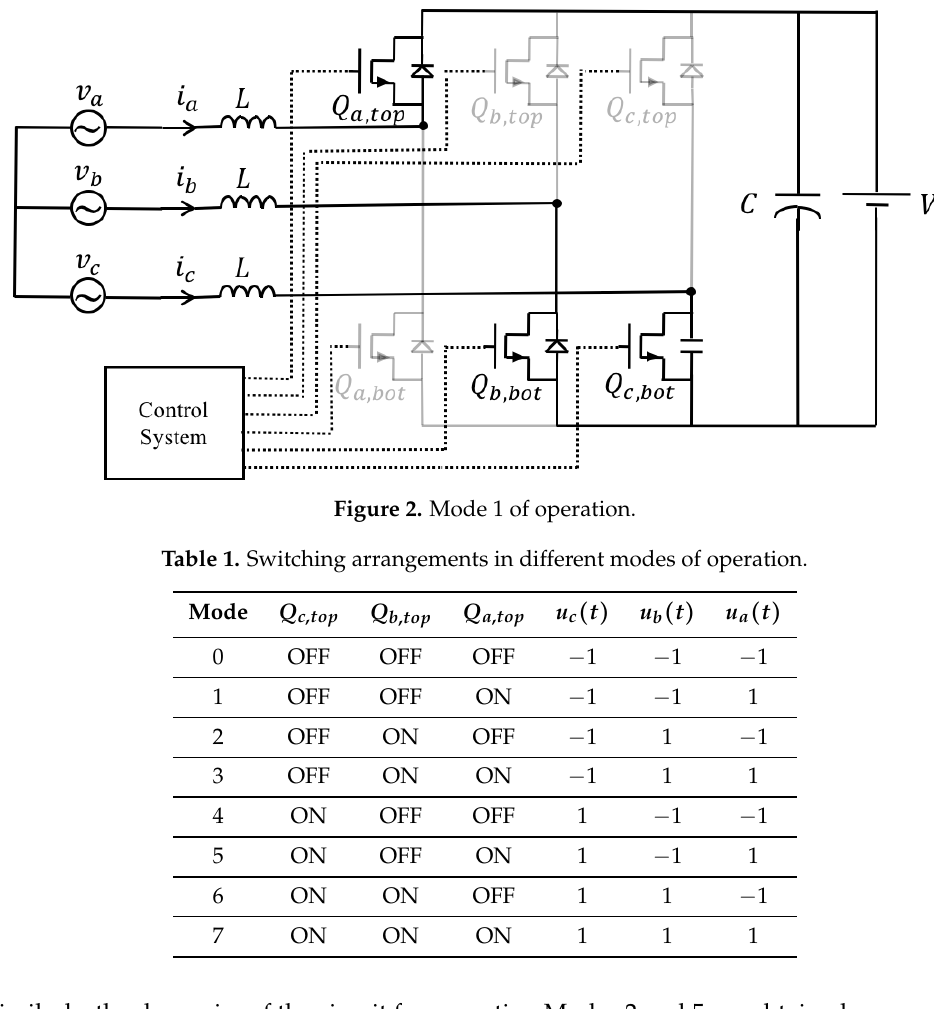
Figure 1. Bidirectional three-phase single-stage converter.